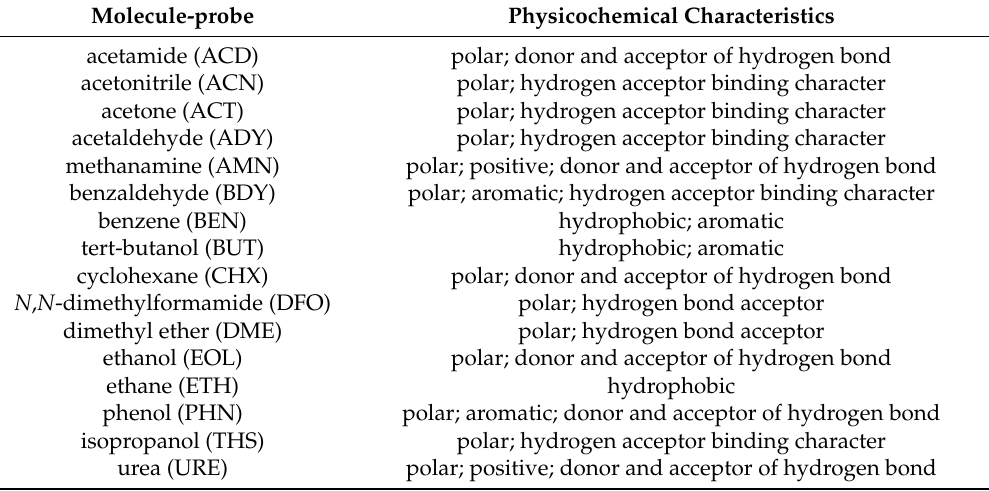
Table 2. Main characteristics of the probe molecules used by FTSite and